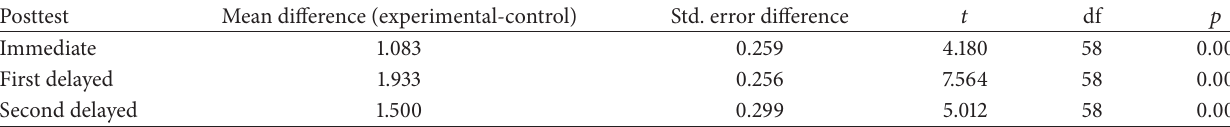
Table 12: Independent samples t -tests for the productive